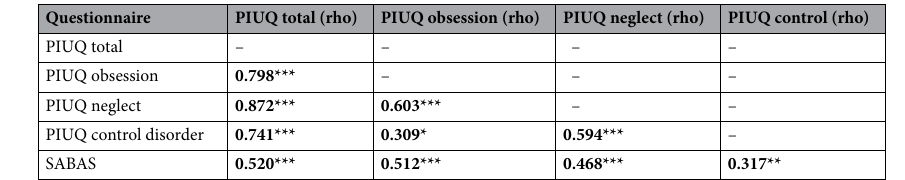
Table 3. Correlational analyses of questionnaire data. Rho–Spearman’s correlation coefficient; PIUQ Problematic Internet Use Questionnaire; SABAS Smartphone Application-Based Addiction Scale; * P < 0.05, ** P < 0.01, *** P < 0.001; Significant correlations after Benjamini–Hochberg correction are written in bold.